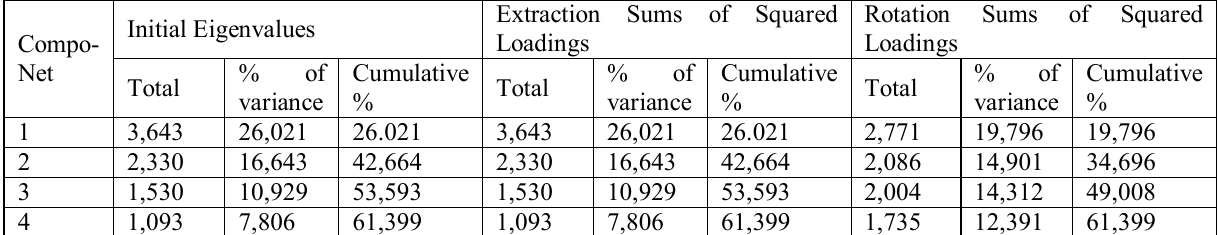
Table. 2. Total Variance